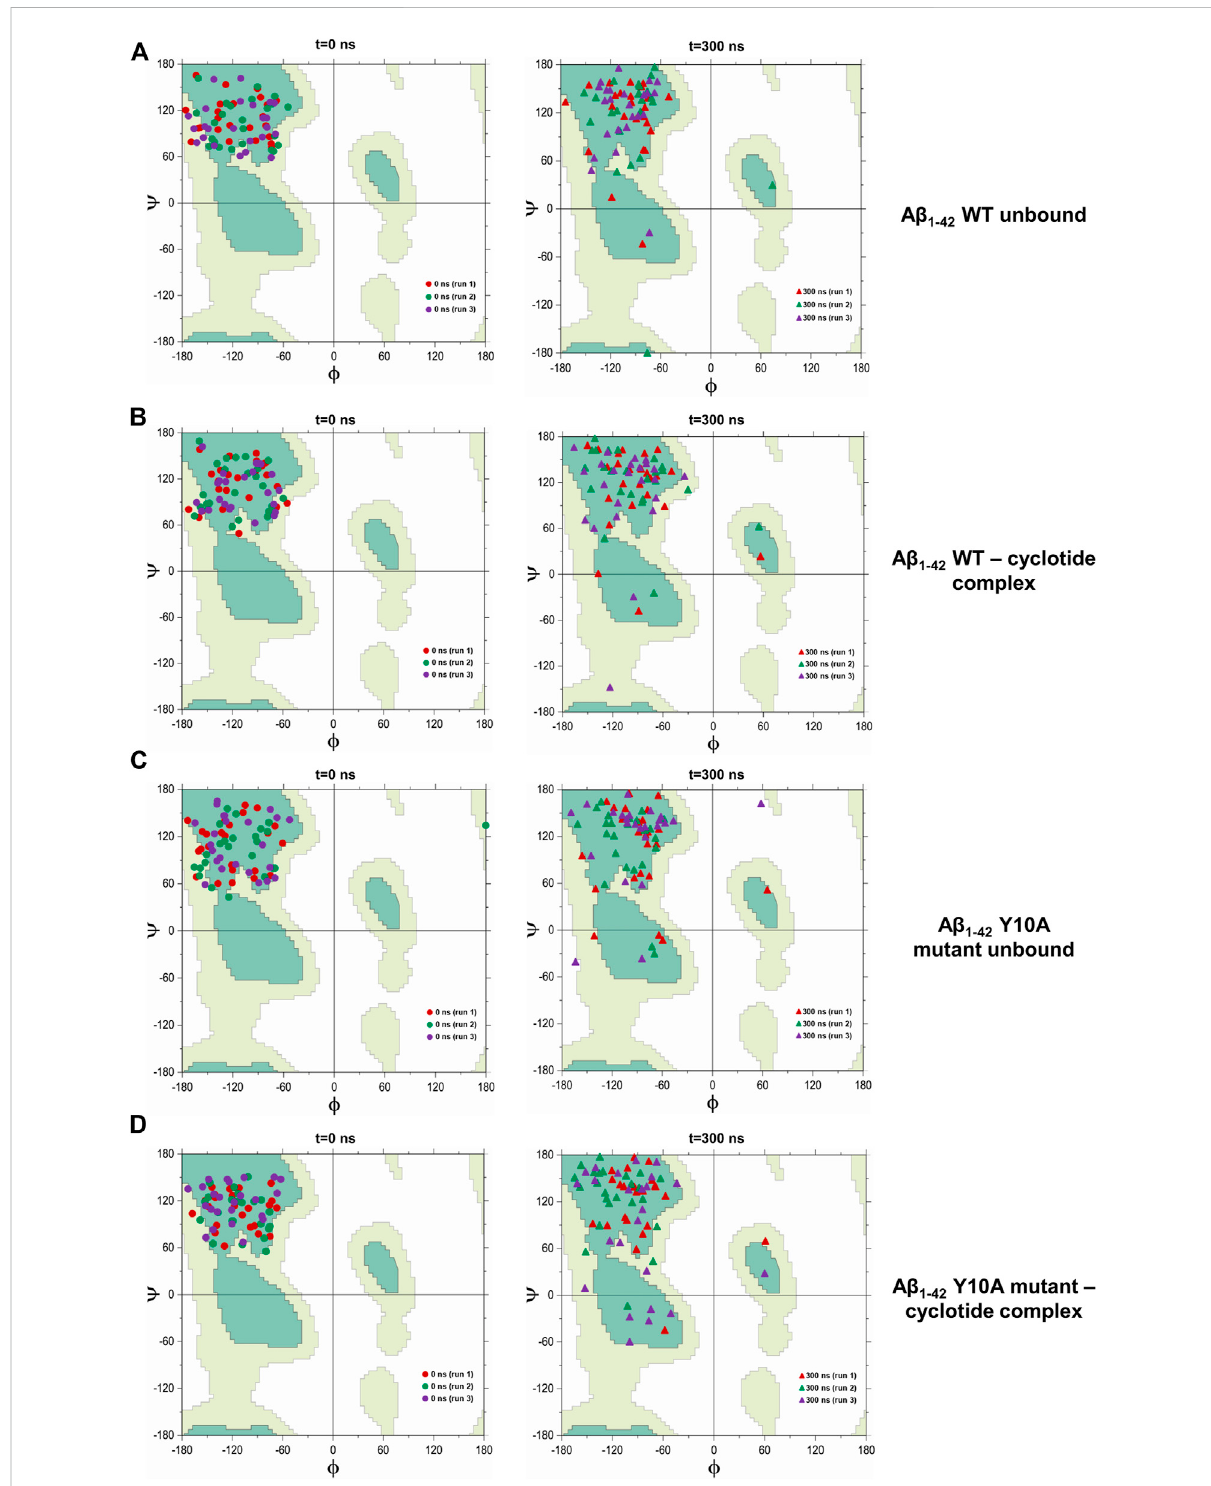
FIGURE 4 Scatterplotin φ – ψ spaceforresidues2 – 6(chainsA-C)and39 – 41(chainsD-F)inthecyclotidebindingpocketfor (A) unboundwild-typeA β 1-42 , (B) wild-type A β 1-42 — cyclotide complex, (C) A β 1-42 Y10A mutant unbound and (D) A β 1-42 Y10A mutant — cyclotide complex, at the beginning (0 th ns) and end (300 th ns) of simulation trajectories. Fully allowed and favourable regions in the φ – ψ space are shown in the background of